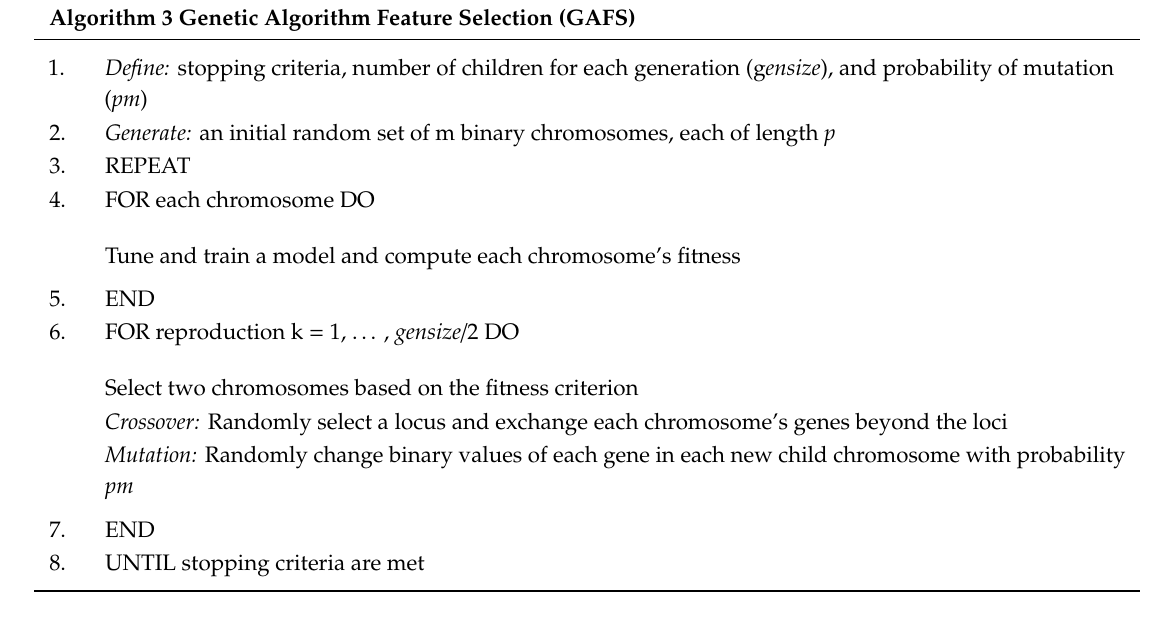
Algorithm 3 Genetic Algorithm Feature Selection